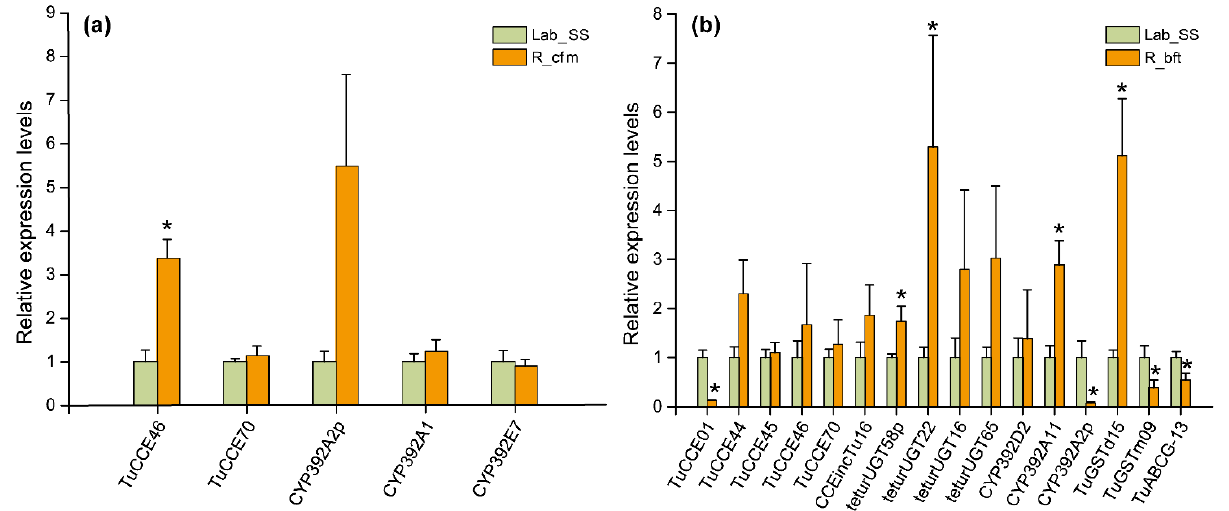
Figure 9. Validation of the transcriptome sequencing results by quantitative real ‐ time PCR. ( a ) Comparison between the susceptible strain (Lab_SS) and the cyflumetofen ‐ resistant strain (R_cfm) of T. urticae . ( b ) Comparison between the Lab_SS strain and the bifenthrin ‐ resistant (R_bft) strain of T. urticae . * indicates the significant difference ( p < 0.05) compared with the Lab_SS. In the strain of Lab_SS vs R_bft, the qRT ‐ PCR data were almost consistent with the RNA ‐ seq analysis (Figure 9b). Four genes, including teturUGT22 , teturUGT58p , CYP392A11 and TuGSTd15 , were significantly upregulated, whose expressions were 5.29 ‐